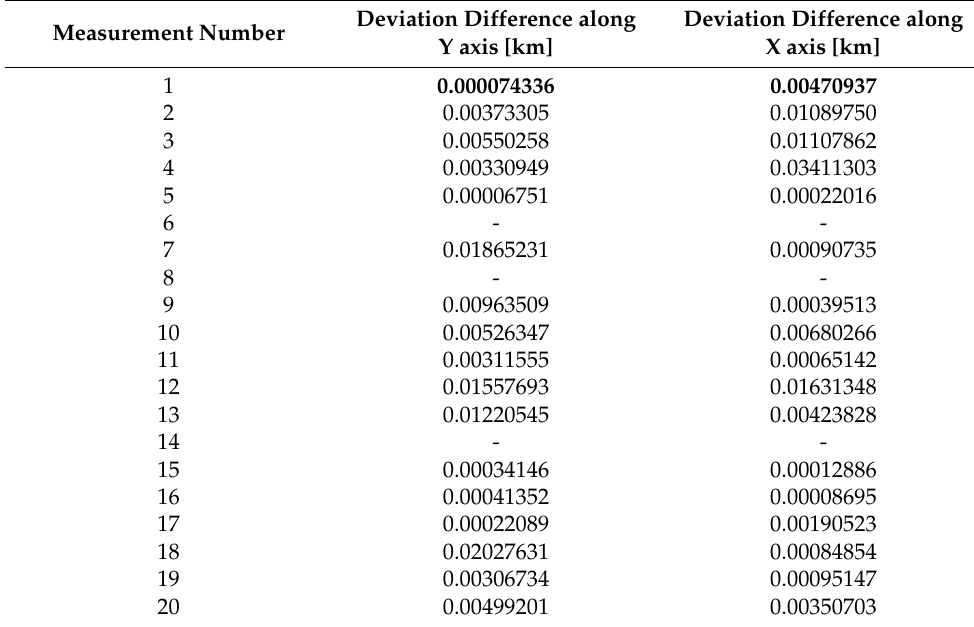
Table 4. Differences in the standard deviations for all